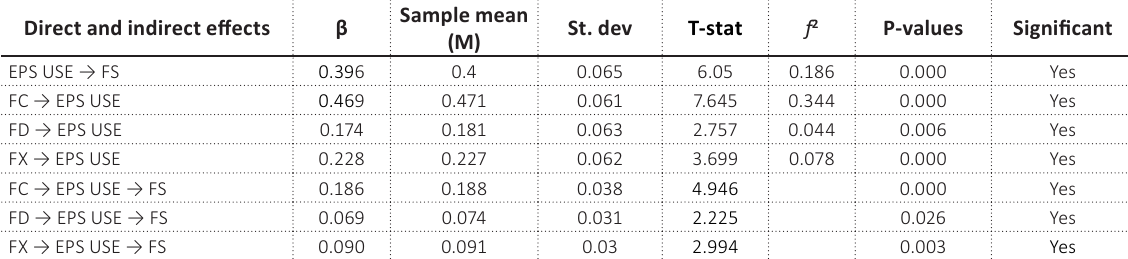
Table 5. Path coefficient Direct and indirect effects